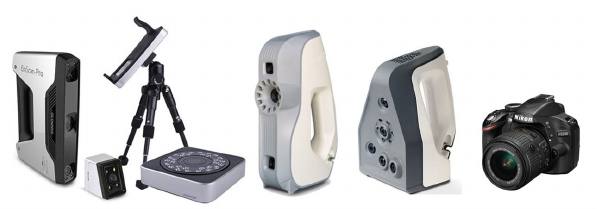
Figure 2. From left to right: Einscan-Pro, Artec Eva, Artec Spider, Nikon